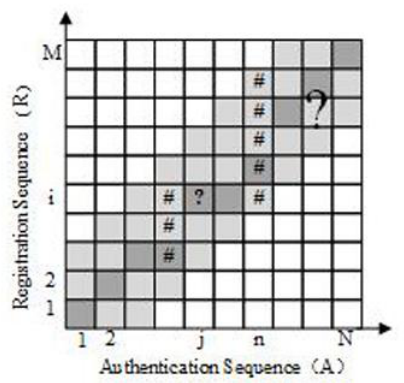
Figure 4 . Early Termination of Authentication (If “#”overflow, “?”must